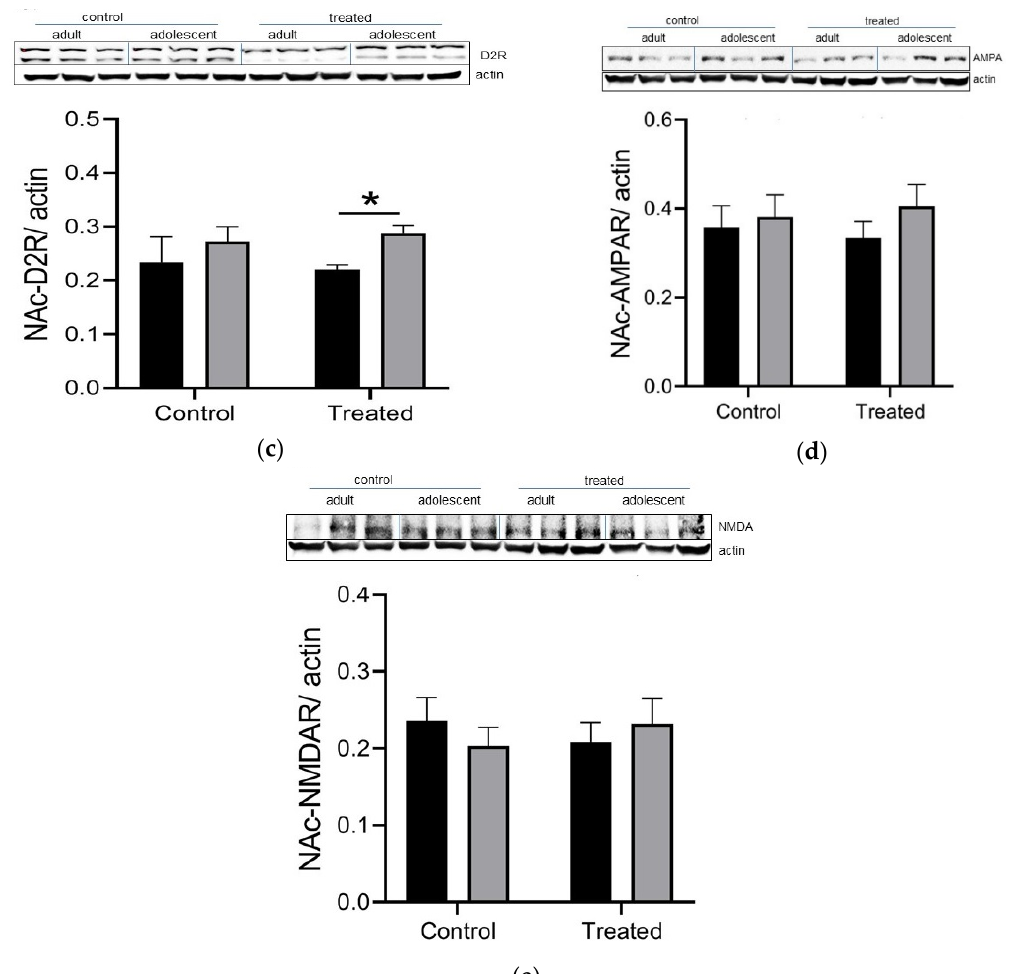
Figure 4. Expression of DAT and dopamine (D 1 and D 2 ) and glutamate (AMPA and NMDA) receptors in control and treated groups. Data represent the ratio of ( a ) dopamine transporter (DAT), ( b ) dopamine D1 receptors (D 1 R), ( c ) dopamine D2 receptors (D 2 R), ( d ) NMDA receptors, and ( e ) AMPA receptors over beta-actin as well as their corresponding representative bands from adult male and female mice and were analyzed by two-way ANOVA, and then subjected to between-group comparisons using the Fisher’s least significant difference test. ( a ) ** p < 0.01 vs. control group, *** p < 0.001 vs. treated adolescent group; ( b ) * p < 0.05 vs. treated adolescent group; ( c ) * p < 0.05 vs. treated adult group. Each band represents an individual mouse (8–10 samples per treatment/sex and each